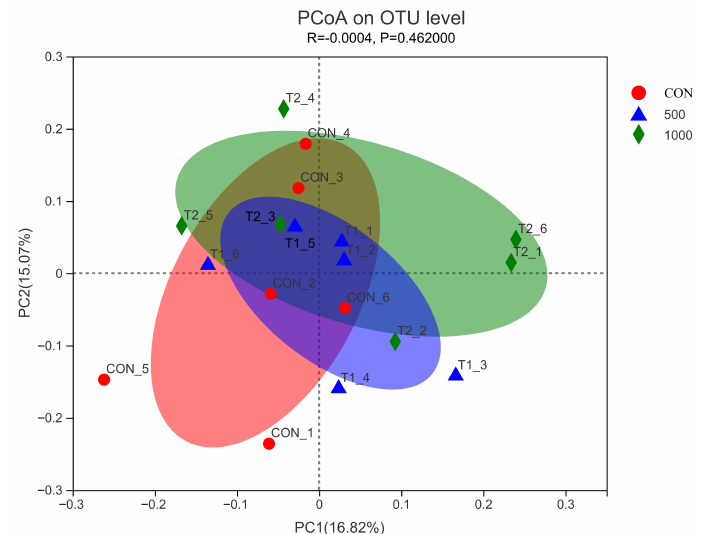
Figure 2. PCoA analysis of caecal microflora in aged laying hens.